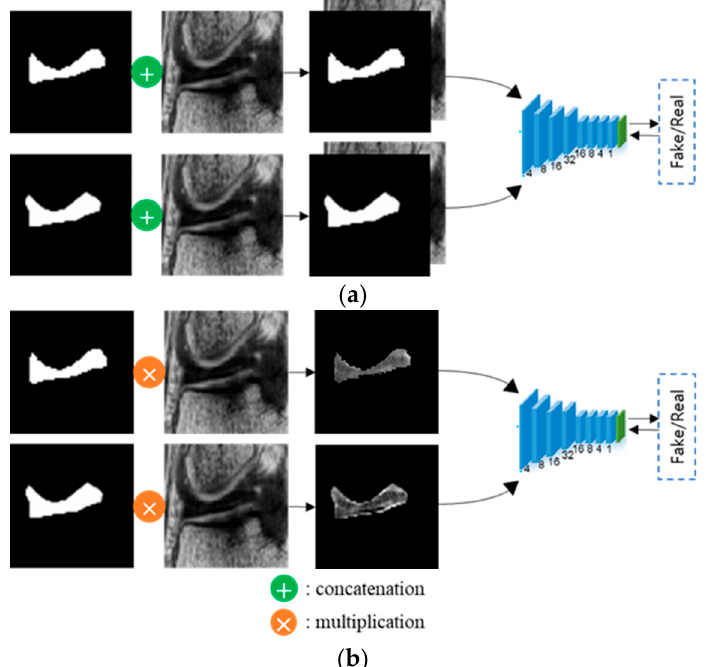
Figure 4. Architecture of the discriminator of the conventional adversarial network and the proposed adversarial network using an object ‐ aware map: ( a ) Conventional adversarial network; ( b ) Adversarial network using object ‐ aware map.